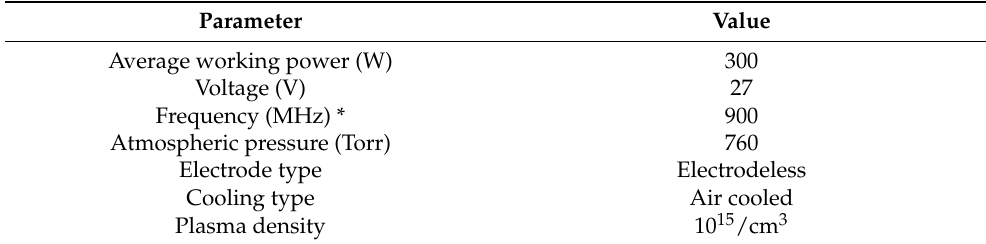
Table 4. Parameters of plasma